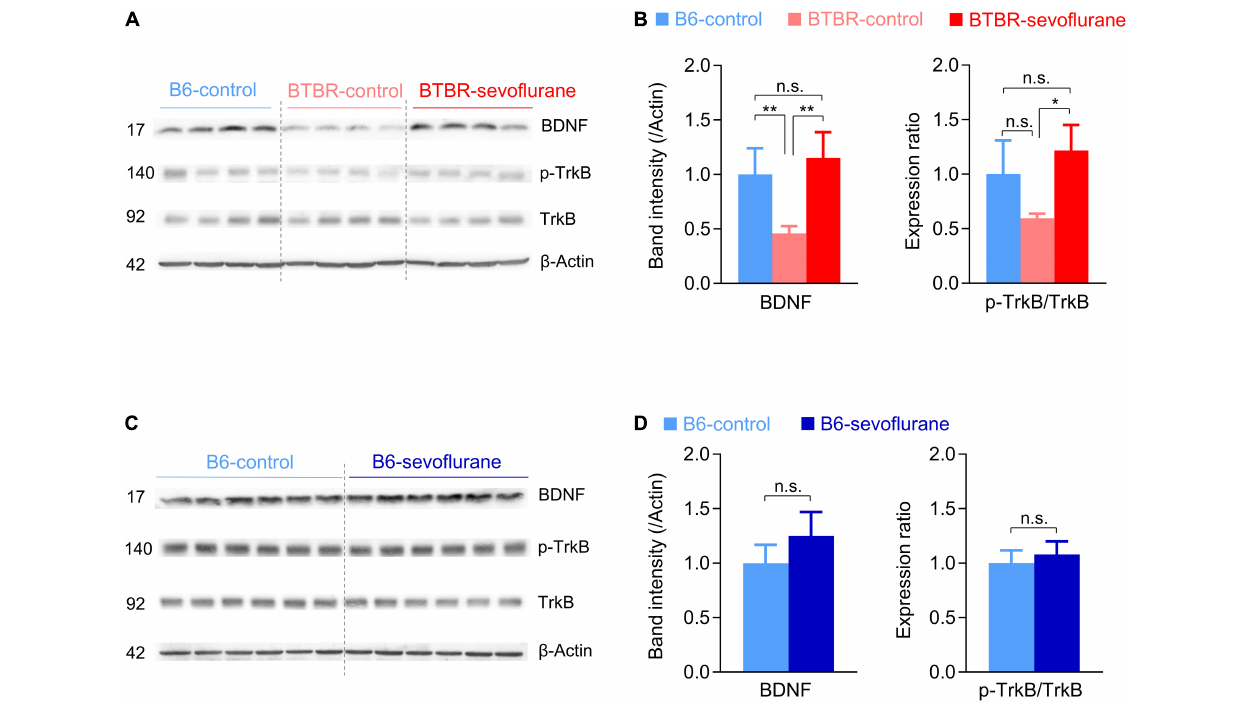
FIGURE 3 | Sevoflurane exposures increase BDNF/TrkB signaling in late postnatal BTBR mice. (A–D) Expression levels of BDNF and TrkB were measured in cerebral cortex samples obtained 5 days after sevoflurane exposures. (A,B) Western blot images and quantification of BDNF/TrkB signaling expression in B6-control, BTBR-control, and BTBR-sevoflurane mice ( n = 4 mice for all groups). (C,D) Western blot images and quantification of BDNF/TrkB signaling expression in B6-control and B6-sevoflurane mice ( n = 6 per group). Numbers on the left indicate protein size (kDa). Values are presented as mean ± SD (* p < 0.05, ** p < 0.01, n.s., not